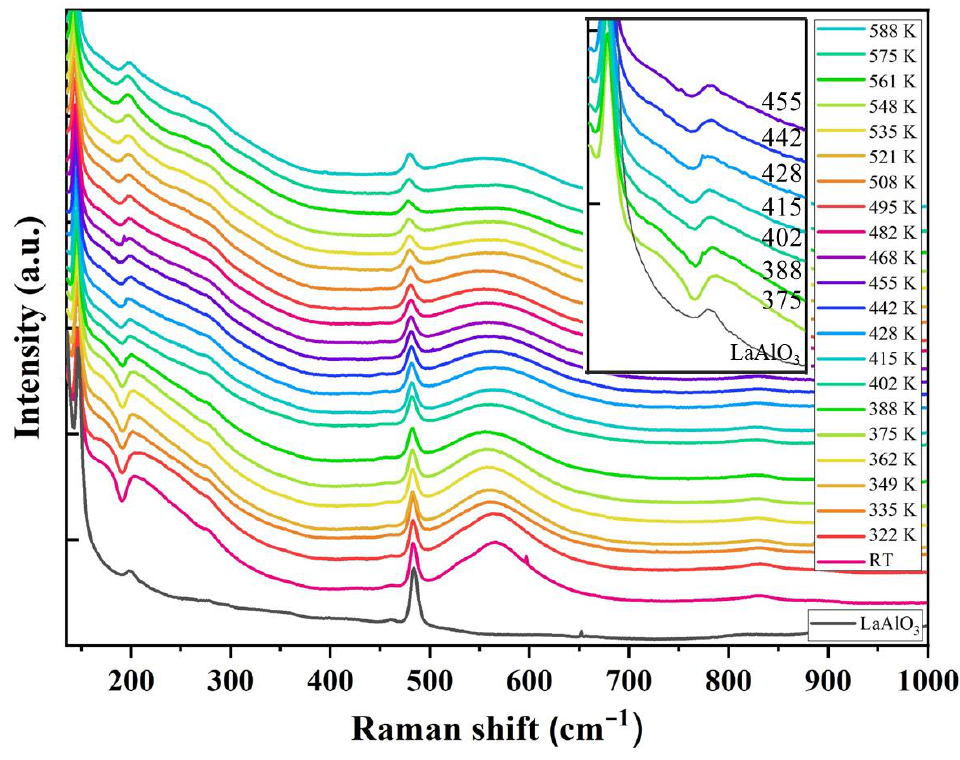
Figure 6. Temperature-dependent Raman spectra of KTN thin film on LaAlO 3 substrate.